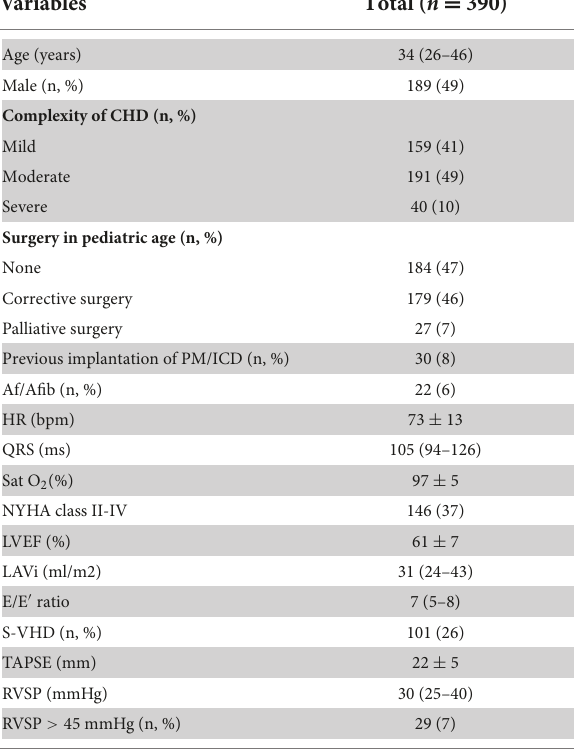
TABLE 1 Baseline characteristics of the study